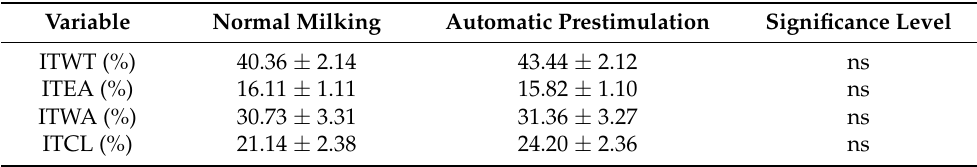
Table 2. Effect of the treatment (normal milking vs. milking with automatic prestimulation) on variables related to teat-end status in Murciano-Granadina goats on the onset of lactation (least square means ± standard error of the mean).